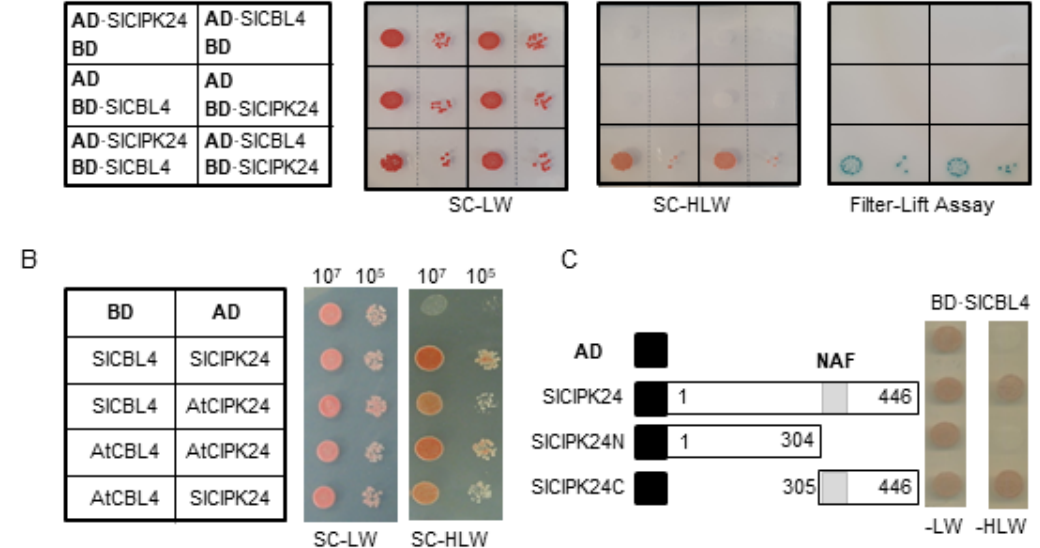
Figure 2. Yeast two-hybrid assays. ( A ) Vector swapping assay. The first panel at left shows the arrangement of the Y190 yeast cells harboring the indicated BD and AD plasmids. The second and third panels display yeast growth on synthetic complete (SC) medium lacking Leu and Trp (SC-LW) and SC medium lacking His, Leu and Trp (SC-HLW), respectively. The last panel shows β-galactosidase activity. ( B ) Comparative interaction analysis. The first panel at left represents the arrangement of the Y190 yeast cells harboring the indicated BD and AD plasmids. Co-transformed yeast cells were cultured, serially diluted, and spotted onto the indicated media. ( C ) Deletion analysis. SlCIPK24 deletion mutants were created in the AD vector and co-transformed into the yeast cells with BD·SlCBL4. Black boxes indicate the activation domain of GAL4 transcription factor. Numbers in the white boxes represent the beginning and the ending positions of each protein fragment. The gray box designates the NAF motif spanning from 307 to 329 amino acids.